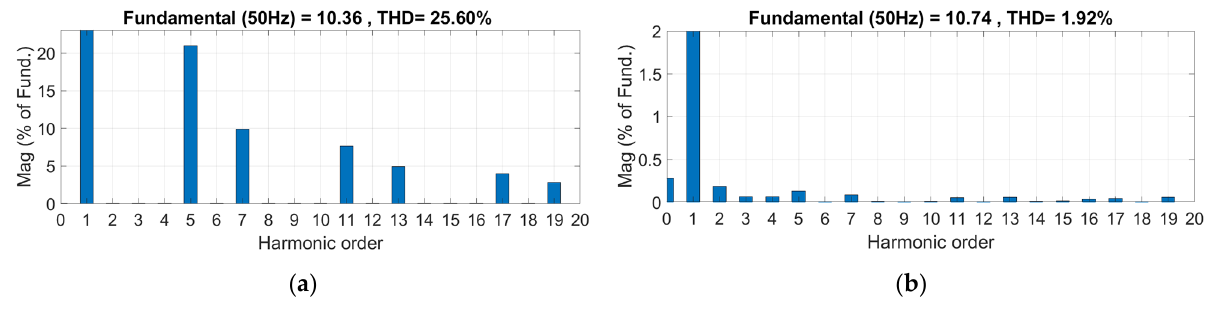
Figure 11. FFT analyzer considering delays for source current ( a ) without APF ( b ) with APF using PQ